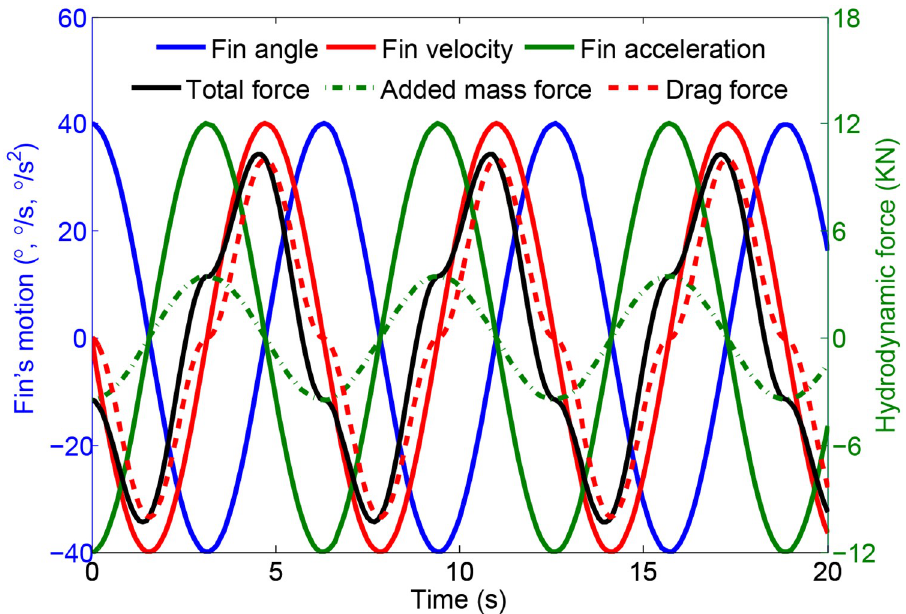
Fig 5. Fin’s movement and hydrodynamic forces generated on